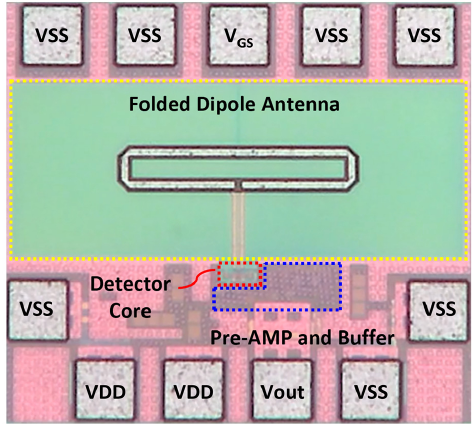
Figure 9. Photograph of the CMOS detector IC for the unit pixel of the proposed array fabricated on the 65 nm CMOS process.